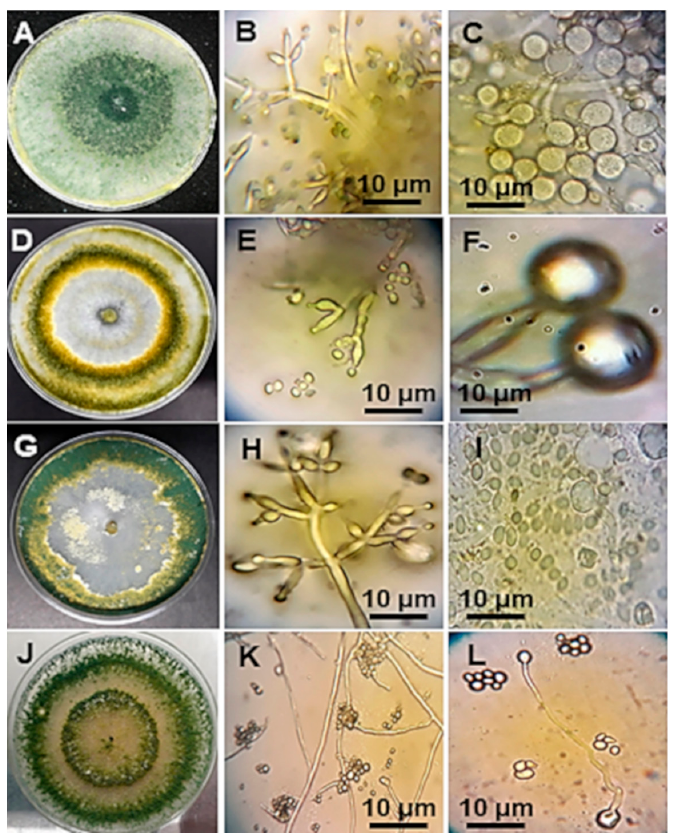
Figure 4. Macro and microscopic characteristics of the indigenous endophytic Trichoderma harzianum ( A – C ), T. hamatum ( D – F ), T. koningiopsis ( G – I ) and T. asperellum ( J – L ) isolated from avocado and cinnamon root sections. ( A ) Colony showing dark green color without the presence of rings. ( B ) Presence of phialides and conidia. ( C ) Globose chlamydospores and germ tubes. ( D ) Colony with dark green tone and yellow color, with abundant mycelia between the two to three bright rings. ( E ) Phialides with conidia. ( F ) Germinating chlamydospores. ( G ) Light to dark green colony with one and two rings. ( H ) Conidiophore- and bottle-shaped phialides. ( I ) Conidia and chlamydospores with germination tubes. ( J ) Light green to dark colony, with a ring and abundant mycelia. ( K ) Slightly balloon like phialides. ( L ) Dehydrated conidia germinating with a thin mycelium and terminal chlamydospore.